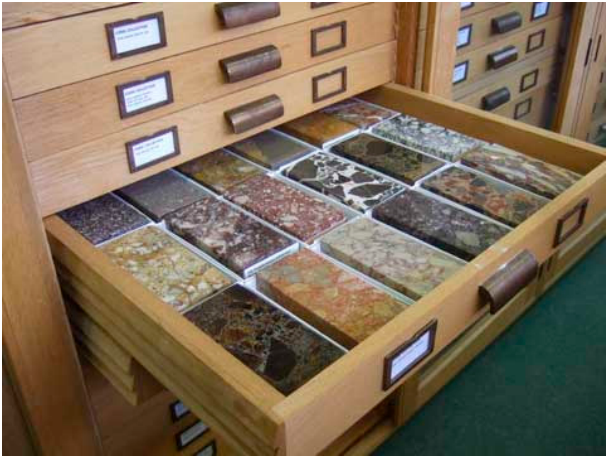
Figure 2. Drawers with Corsi’s collection, by permission of Monica Price, Head of Earth Collections at Oxford University Museum of Natural History. Oxford University Museum of Natural